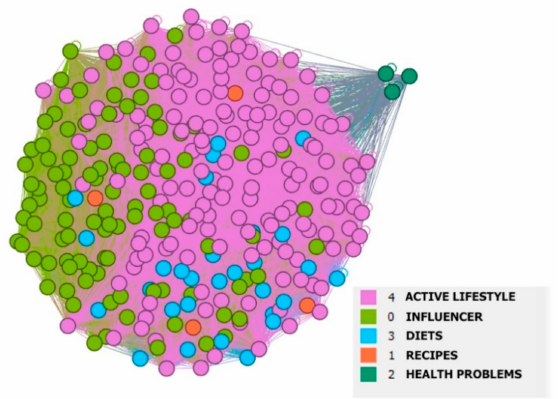
Figure 3. Community visualization on the Twitter social network in the area of healthy